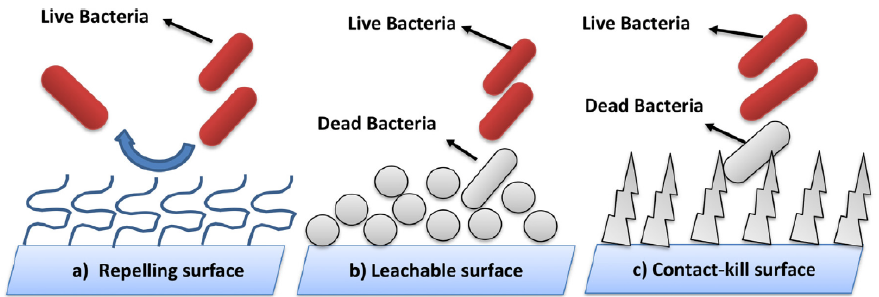
Figure 3. ( a – c ) Three categories of self-disinfection surfaces [93].